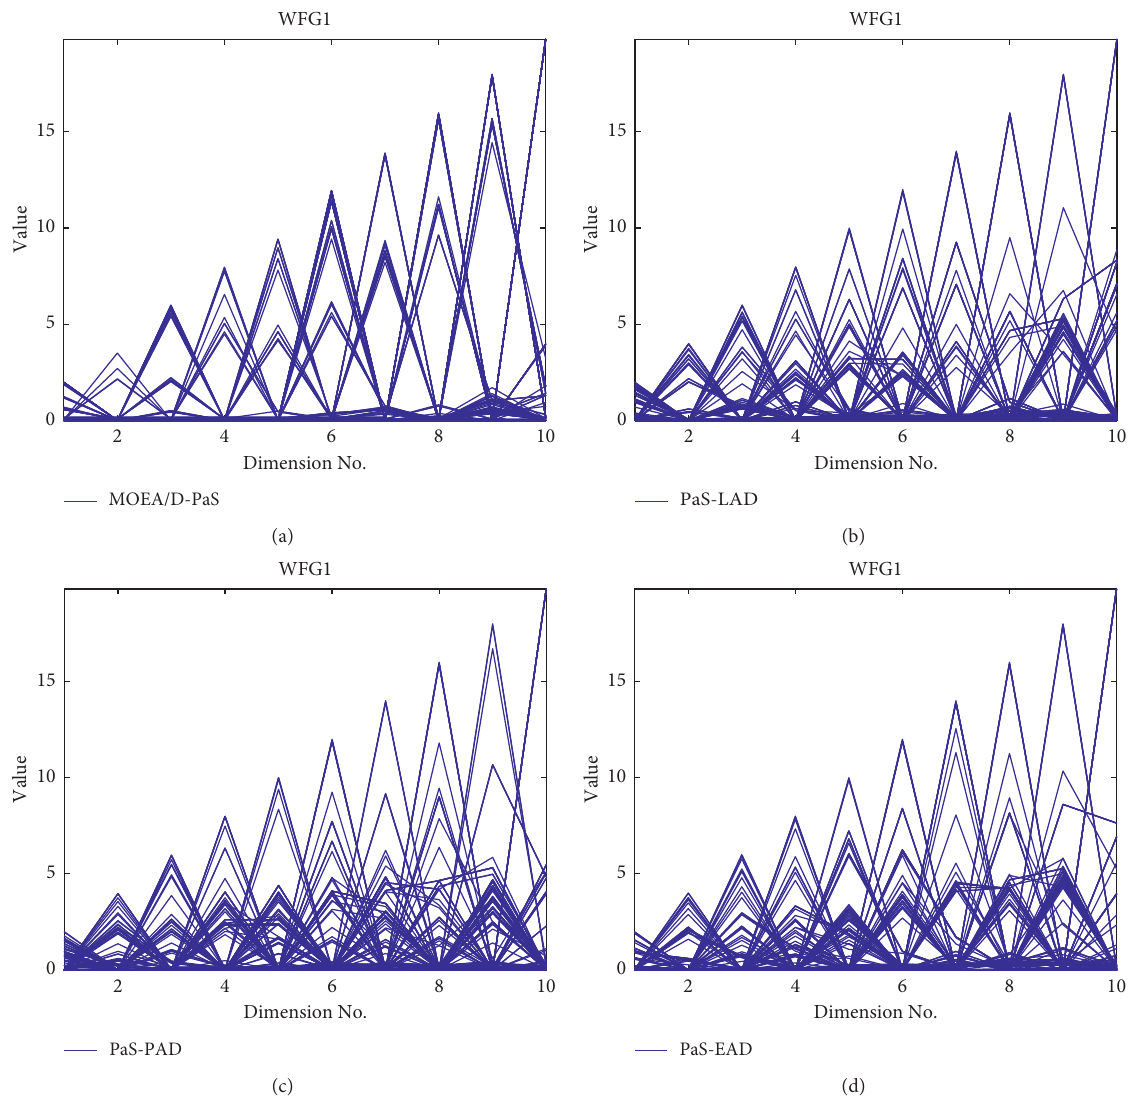
Figure 5: Visualization of PF approximation by four algorithms on the 10-objective WFG1: (a) MOEA/D-PaS, (b) PaS-LAD, (c) PaS-PAD, and (d)